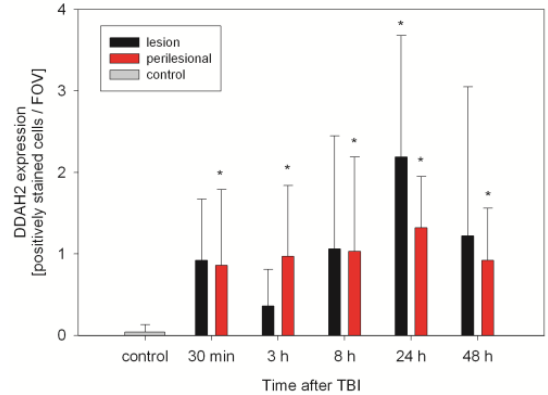
Figure 7. Expression of DDAH2 after CCII (sections of n = 6 animals at each time-point) within the TBI lesion and perilesional area as well as in control animals, expressed as positively stained cells per field of view (FOV) at a magnification of 400× (mean ± SD). * significant difference in DDAH2 expression compared to controls.